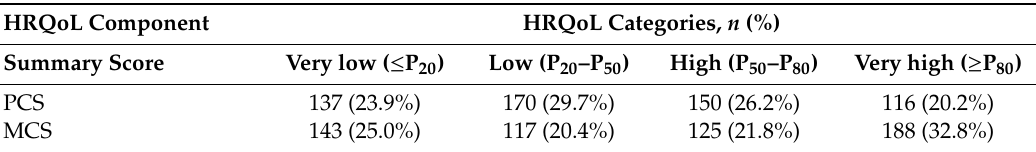
Table 2. HRQoL assessment according to SF-12